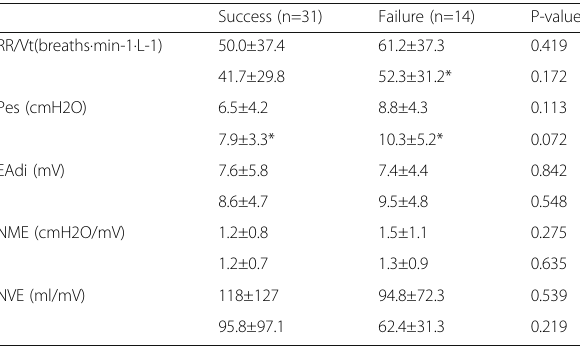
Table 1 (abstract 000951). Physiological parameters at start and end of SBT in both groups